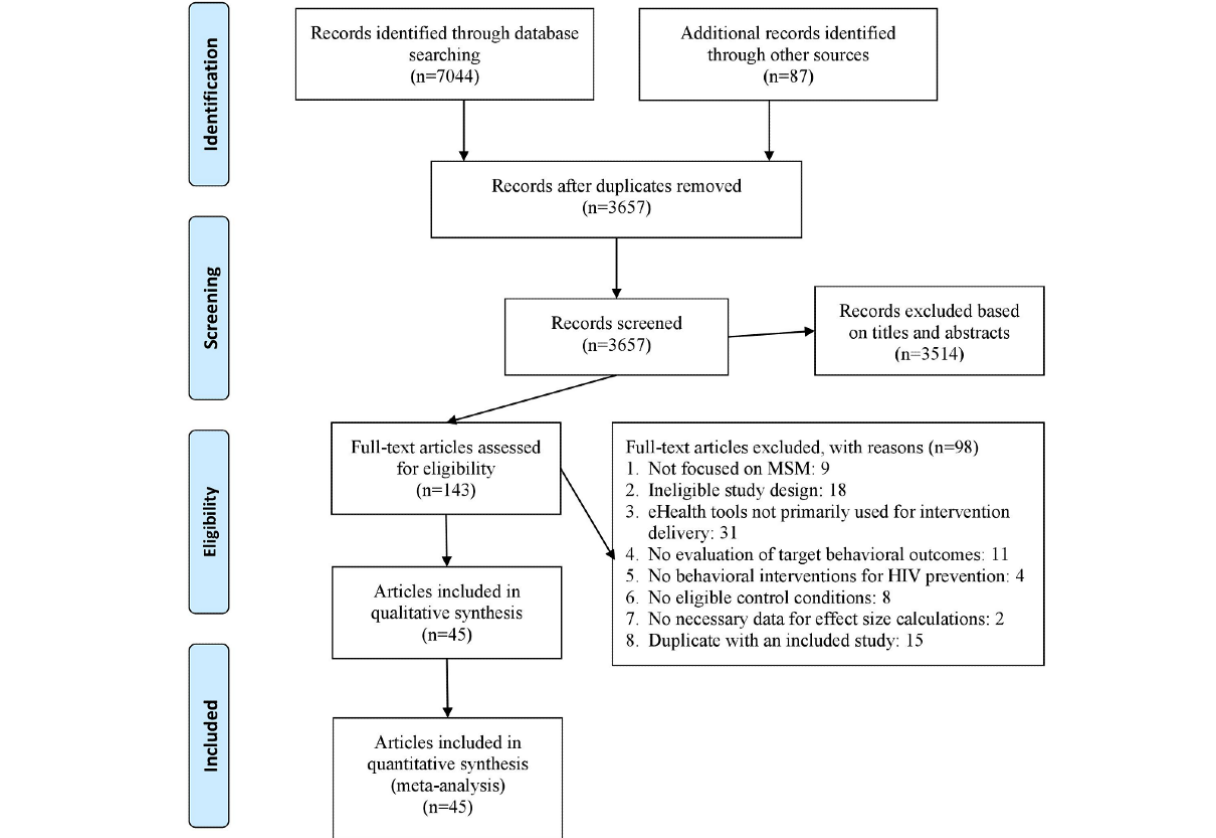
Figure 1. The Preferred Reporting Items for Systematic Reviews and Meta-Analyses flowchart of the screening process. eHealth: electronic health; MSM: men who have sex with